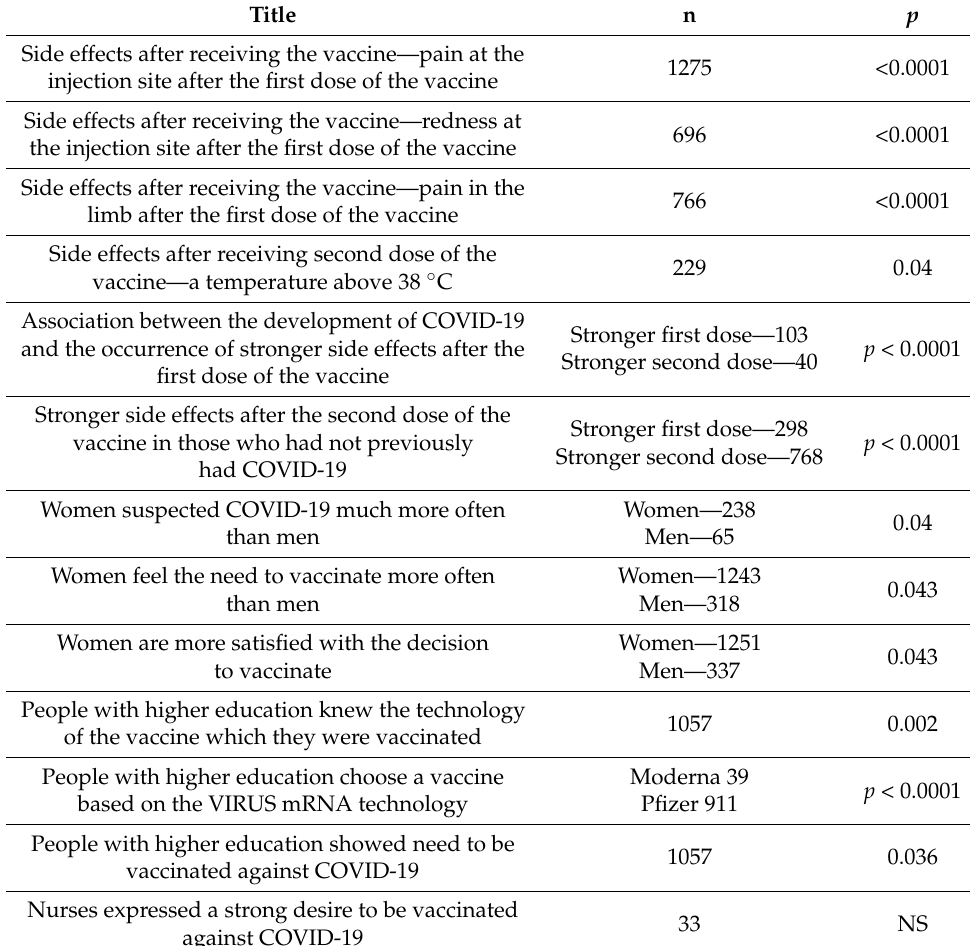
Table 1. Statistical dependencies from the